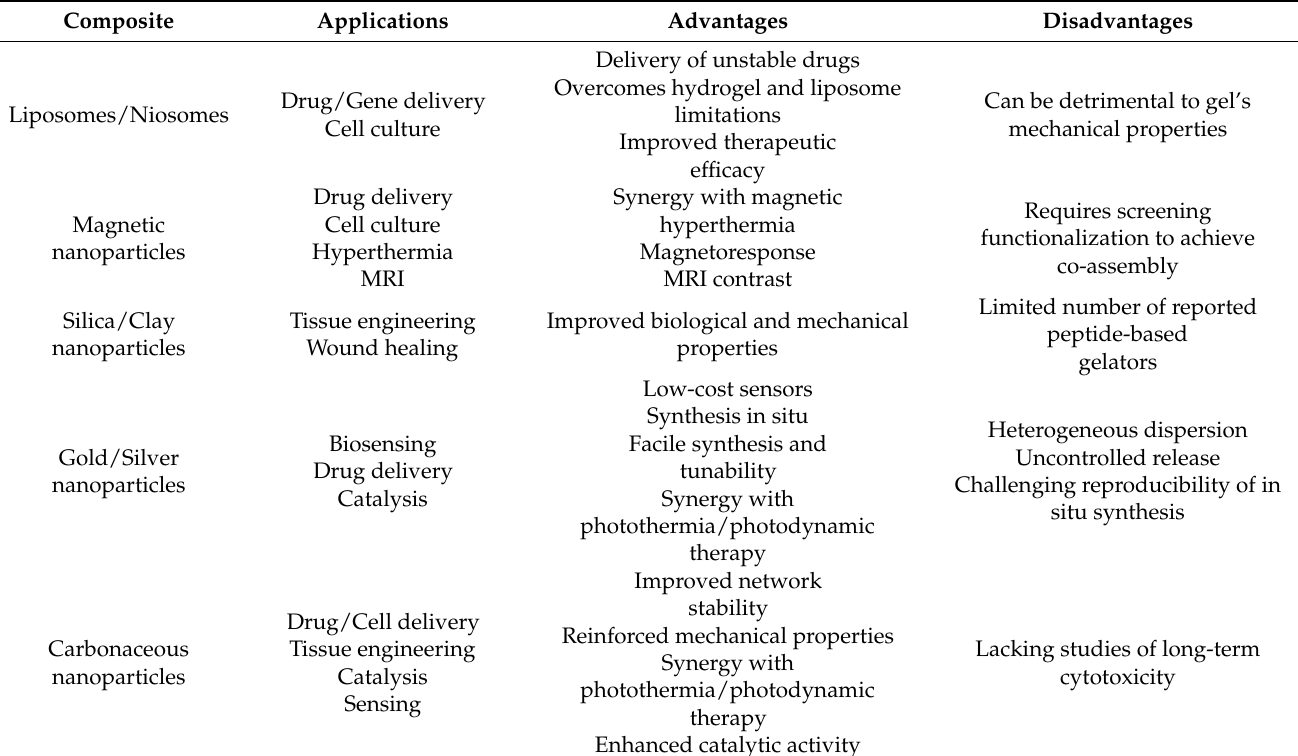
Table 1. Summary of the applications, advantages, and disadvantages associated with the peptide- based hydrogels loaded with the commonly used composites discussed in this review. The disadvan- tages can be transversal to other